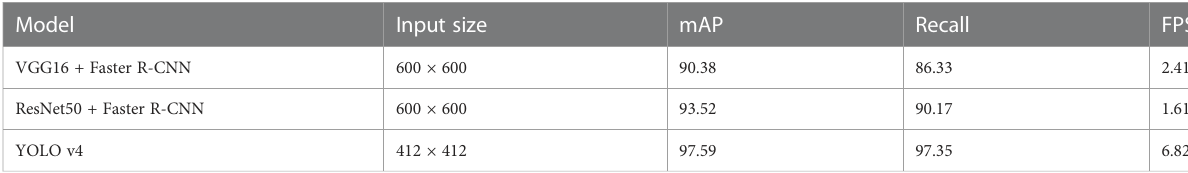
TABLE 3 Comparison between detection accuracy and speed under three